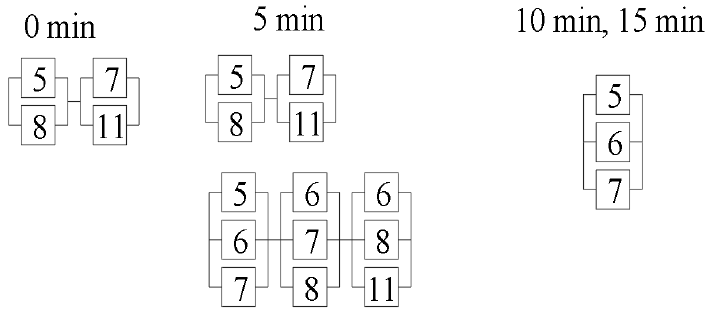
Figure 4. Reduced cut-sets for the structure of the initial static scheme of the truss (Figure 1).